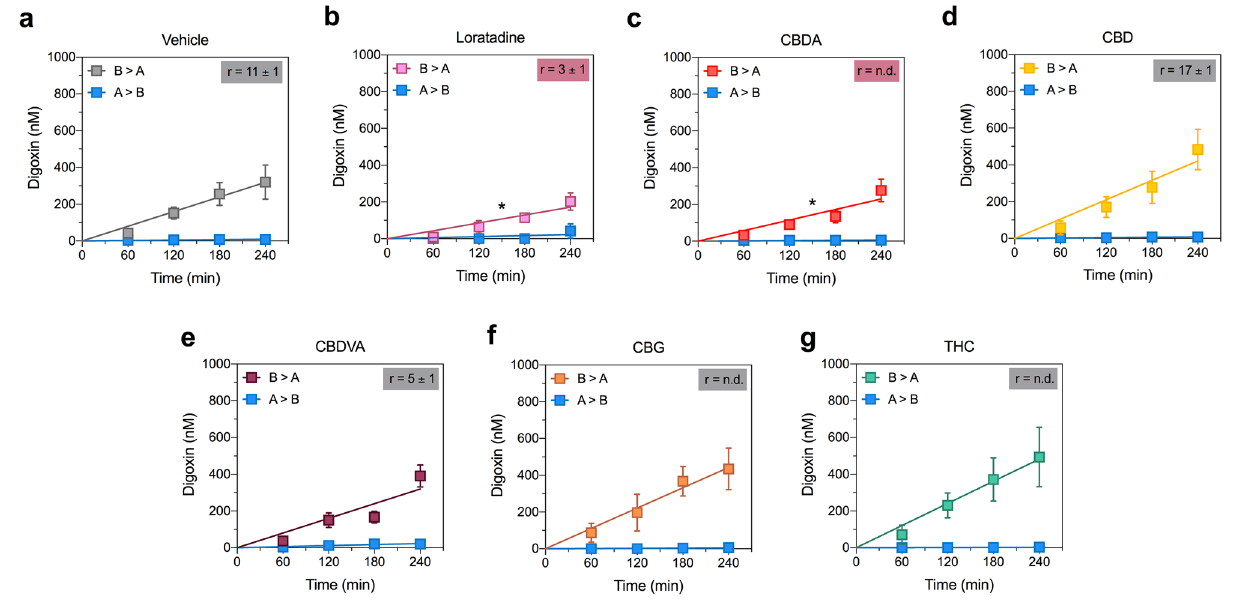
Figure 5. CBDA inhibits P-glycoprotein-mediated transport. Concentration–time curves for prazosin in the presence of ( a ) vehicle, ( b ) loratadine, ( c ) CBDA ( d ) CBD, ( e ) CBDVA, ( f ) CBG or ( g ) Δ 9 -THC in the basolateral to apical (B > A) and apical to basolateral (A > B) directions in cells expressing BCRP. Elacridar and CBD significantly inhibit (red shading) transport of prazosin. Data are expressed as means ± SEM, with n = 3–4 per time point. Curves represent fits to a linear regression and transport efflux ratios (r) are listed (* p < 0.05, compared to vehicle; Extra sum-of-squares F